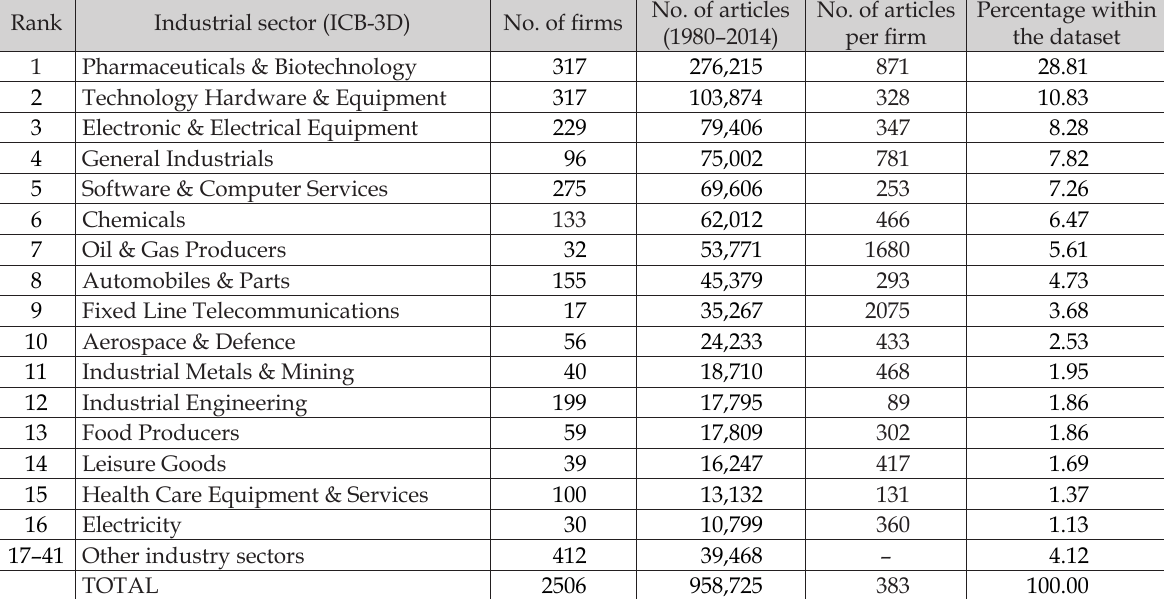
Table 1. Ranking industry sectors by the number of scientific articles published by firms in the period from 1980 to 2014. Rank Industrial sector